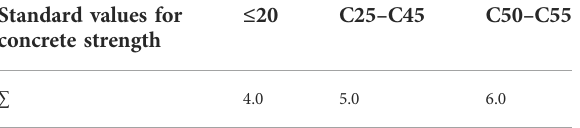
TABLE 5 Standard deviation of concrete strength ( σ ). Standard values for concrete strength